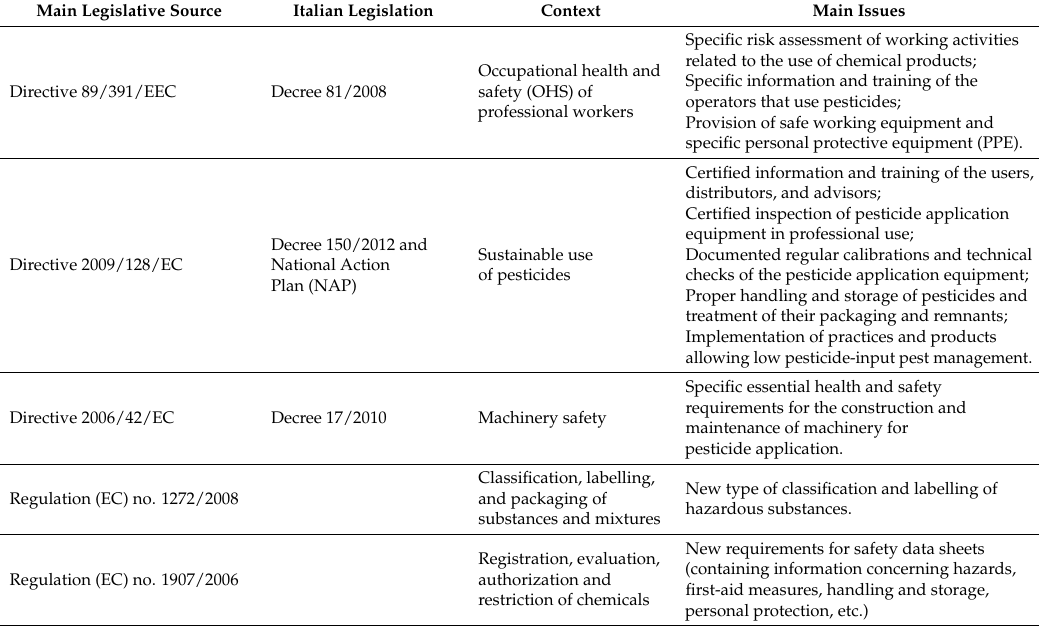
Table 1. EU legislation, its implementation in the Italian legislation, the context, and the related main